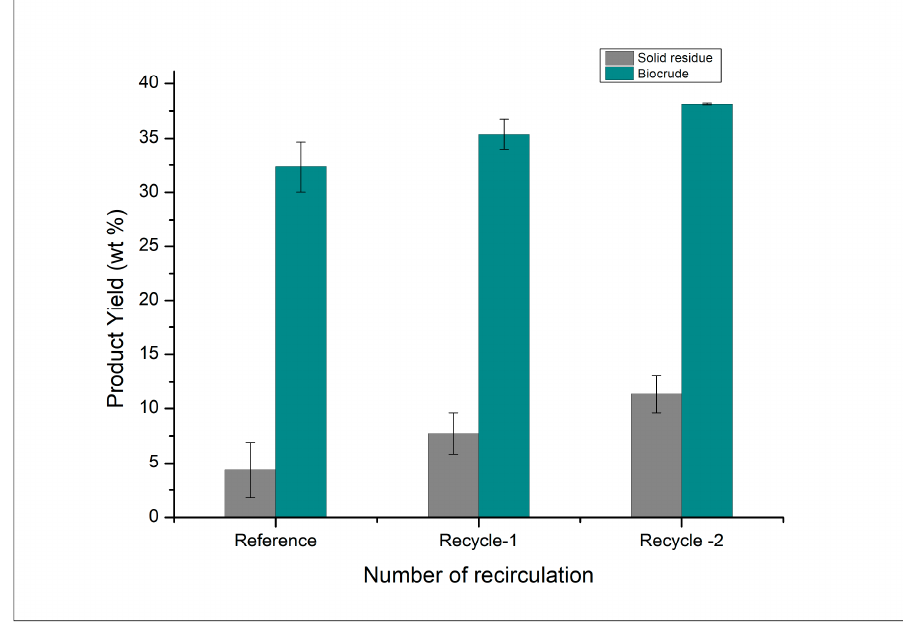
Figure 8. Variation in product yield with aqueous phase recirculation.